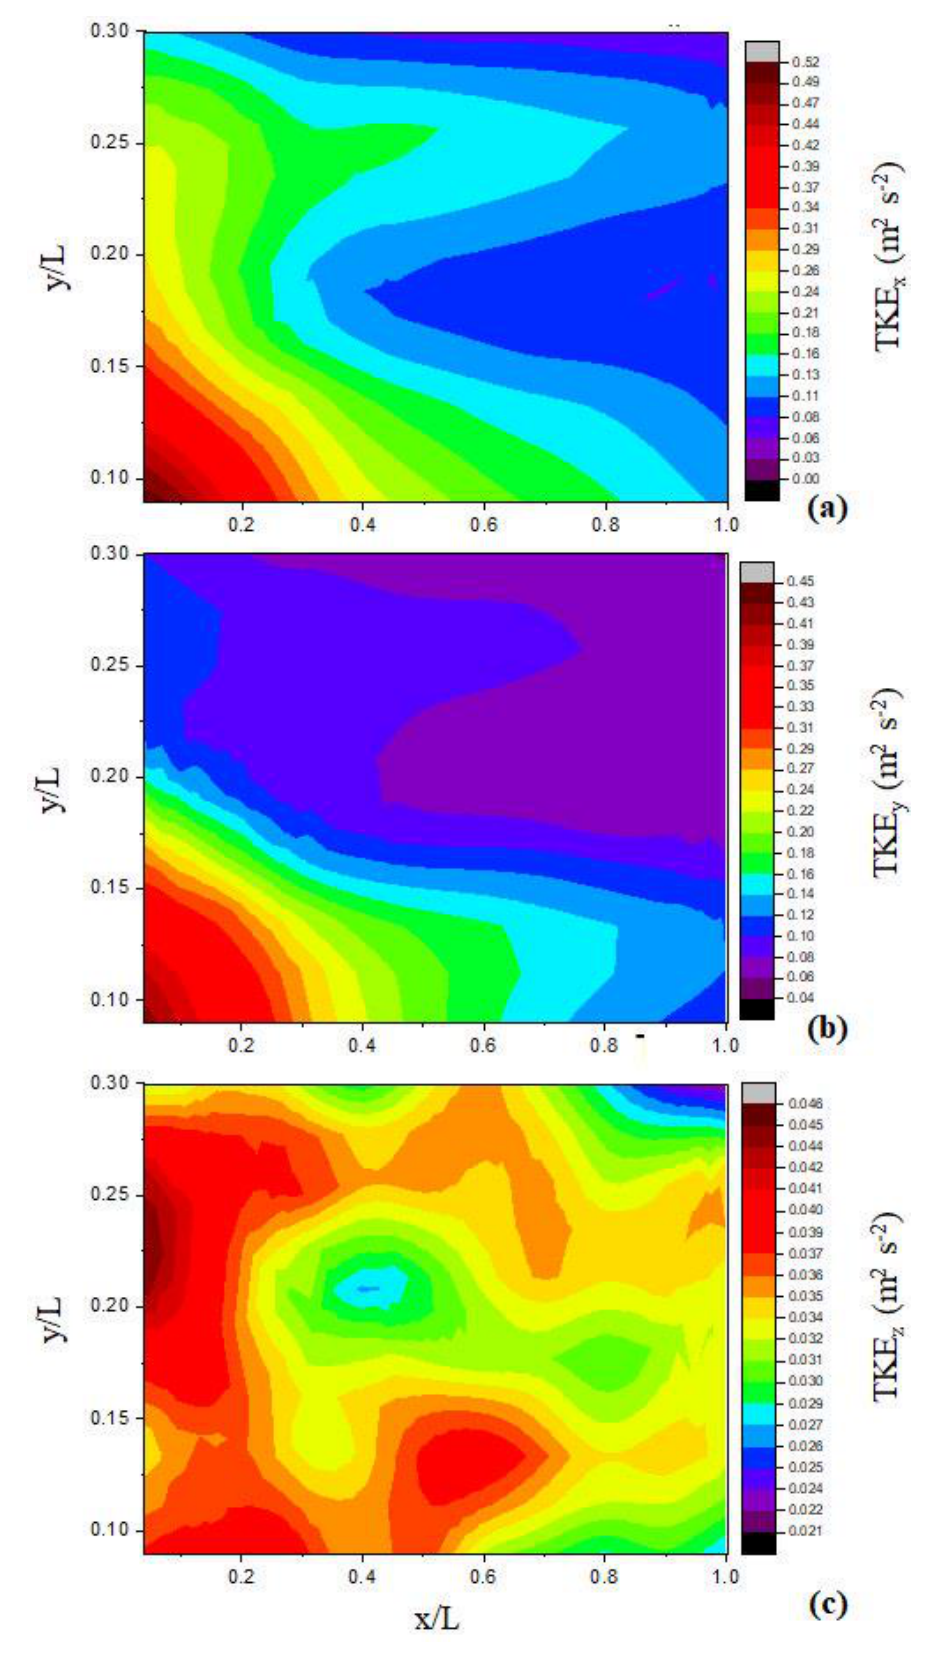
Figure 7. Contour maps of depth-averaged ( a ) TKE x , ( b ) TKE y , and ( c ) TKE z for the experimental run 10R.